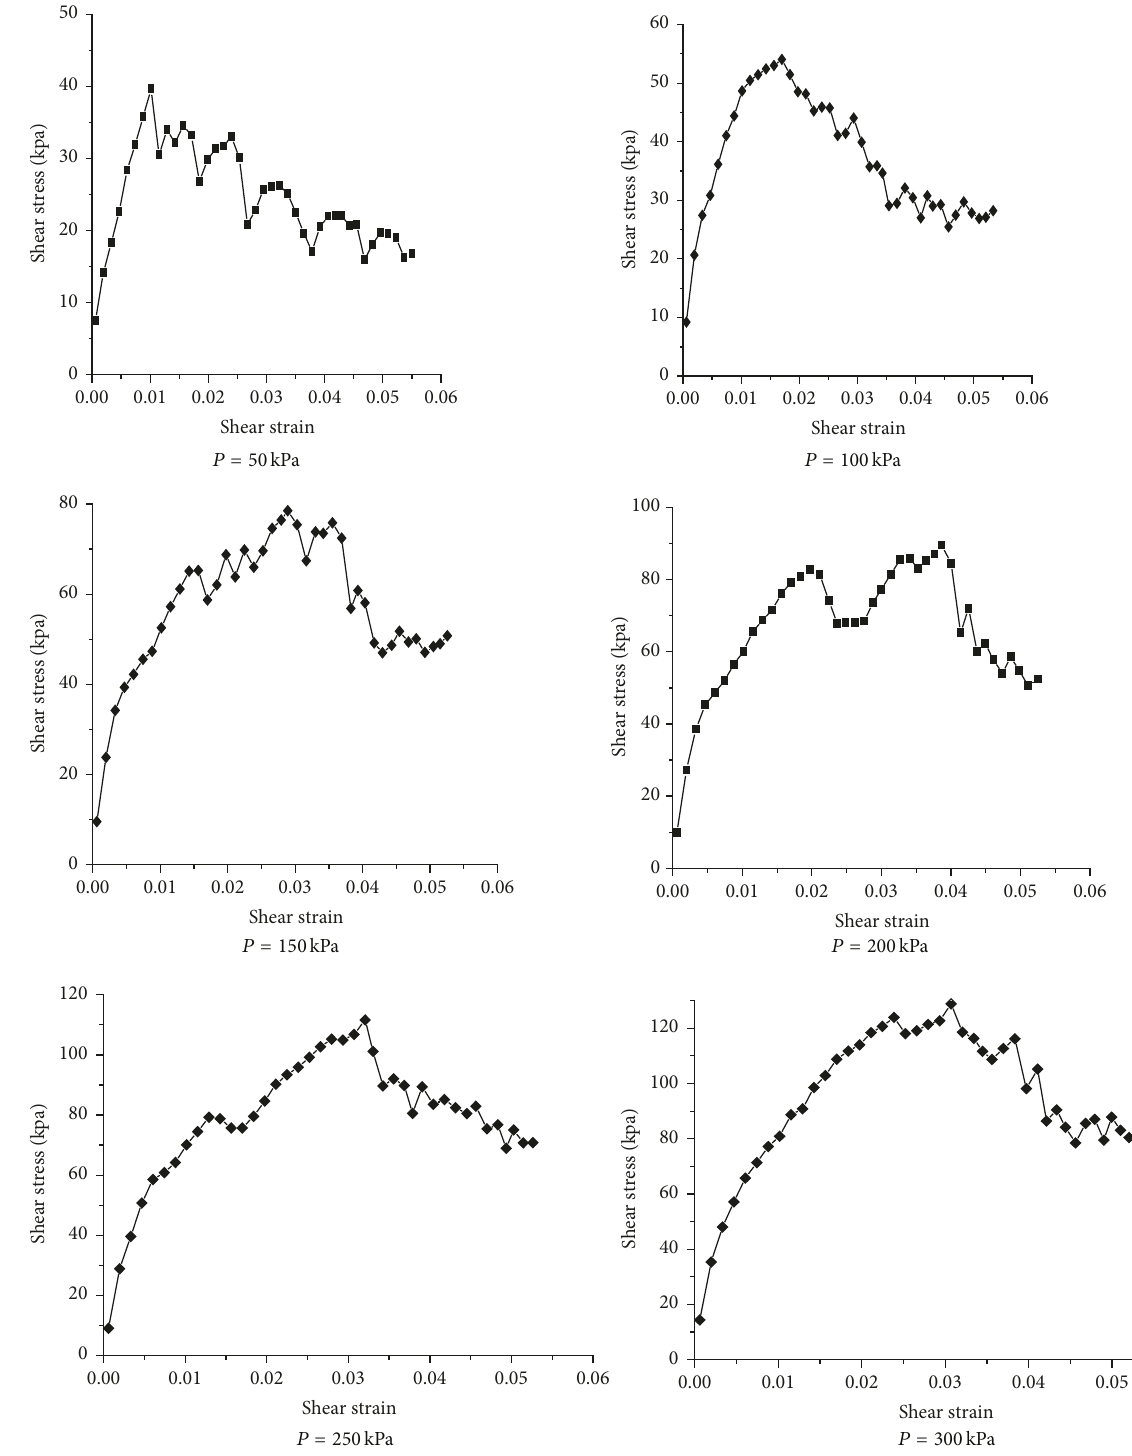
Figure 14: Shear stresses as functions of the shear strains with different normal stresses of 50 kPa, 100kPa, 150kPa, 200 kPa, 250 kPa, and 300